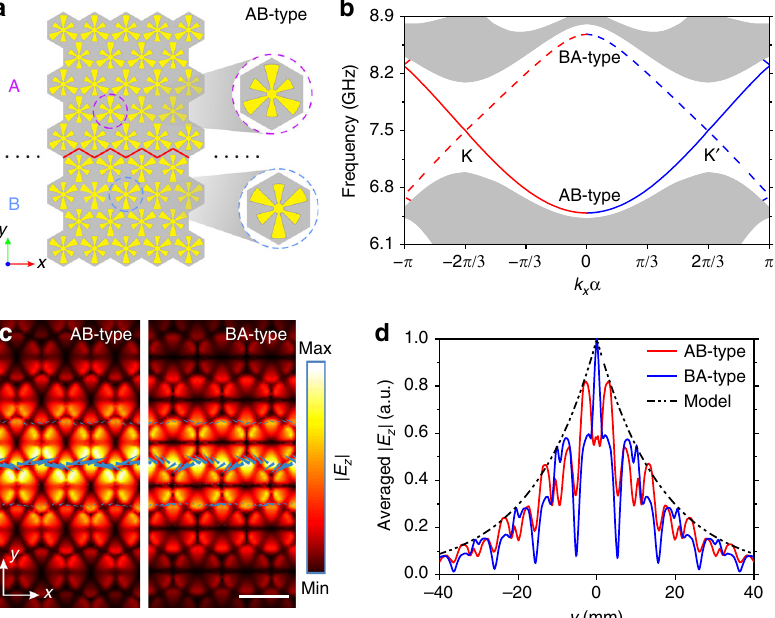
Fig. 3 Edge states at domain walls between two valley-Hall PTIs. a Sketch of an AB-type domain wall, in which pattern A is replicated at the upper domain and pattern B is replicated at the lower domain, respectively. The domain wall is marked by the red solid lines. b Calculated band structure of an AB-type (solid line) domain wall and a BA-type (dashed line) domain wall. The shaded regions represent the projection of the bulk bands. The red lines indicate positive group velocity (forward) and the blue lines indicate negative group velocity (backward). c Simulated fi eld maps of E z component on the xy plane 1 mm above the surface, showing the edge states of AB-type domain wall and BA-type domain wall at the K ′ valley, respectively. The color indicates the amplitude of E z component. The blue arrows represent the energy fl ux. The scale bar is 12 mm. d The averaged | E z | (averaged along the x direction in a unit cell) of the edge states shown in c . The black dash-dotted line represents the corresponding result calculated from the effective Hamiltonian